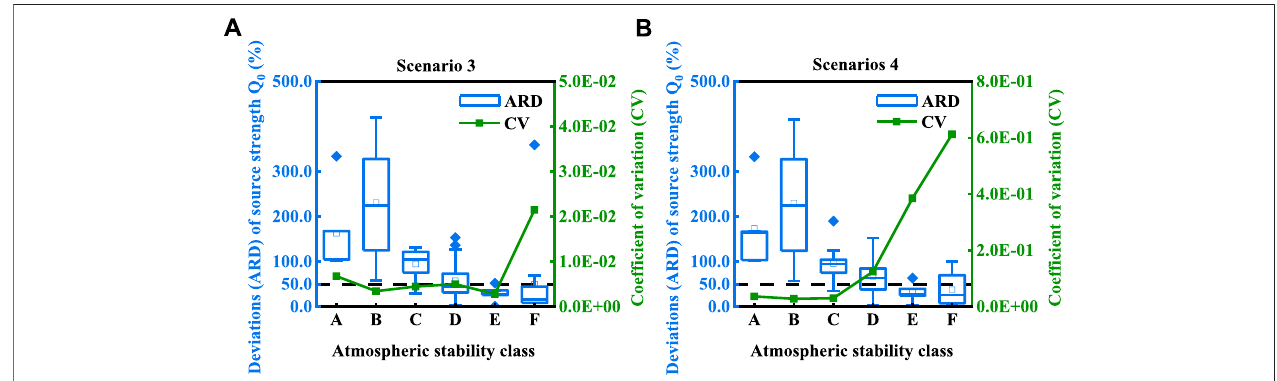
FIGURE5| Boxplotsoftheinversionaccuracyindex(ARD)andlinechartsoftheinversionrobustnessindex(CV)forsourcestrength(Q 0 )estimationunderdifferent applicationscenarios: (A) Scenario3:estimatingbothsourcestrength(Q 0 )andhorizontallocation(x 0 ,y 0 ),and (B) Scenario4:estimatingsourcestrength (Q 0 ),horizontal location (x 0 , y 0 ), and release height (z 0